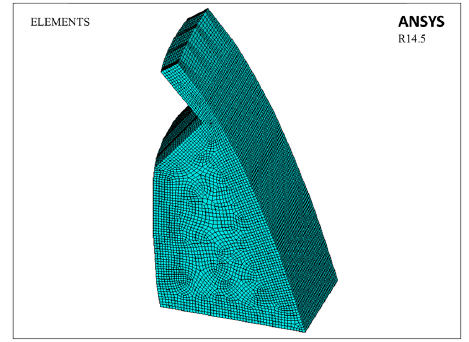
Figure 14. Flowchart of acoustic simulation calculation for cavity. Int. J. Environ. Res. Public Health 2017 , 14 , 1482